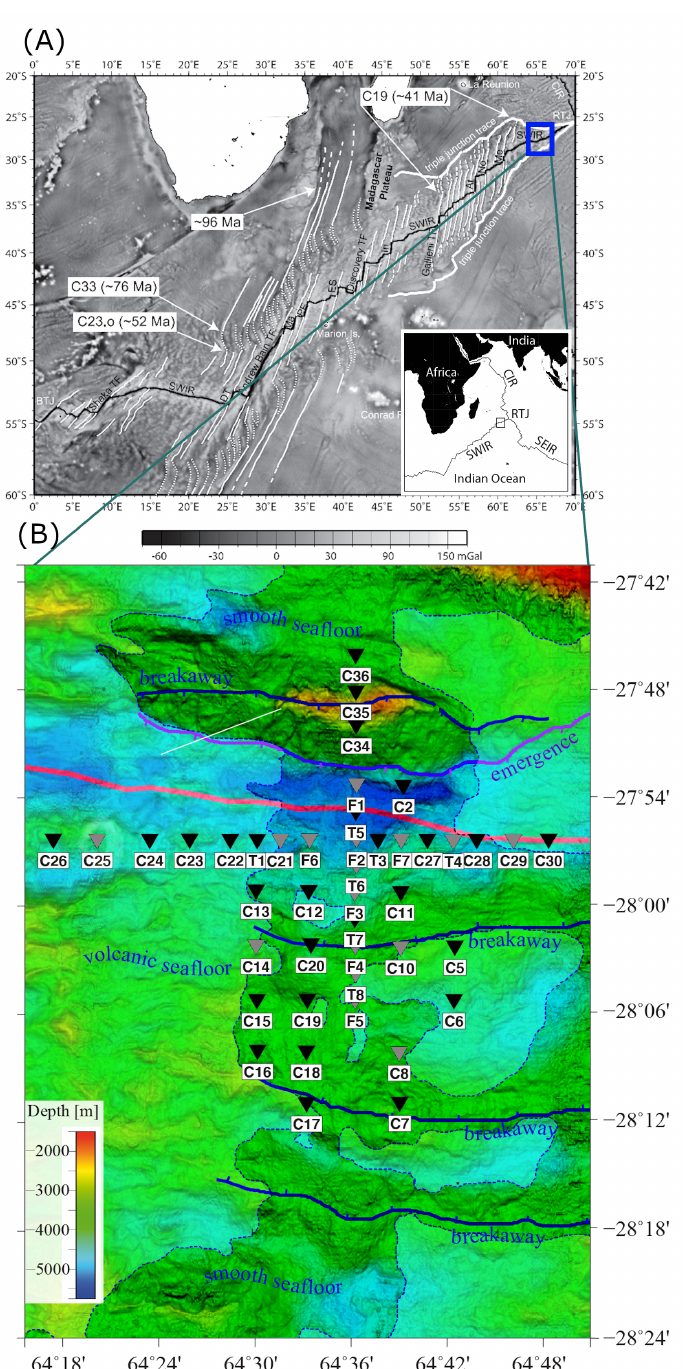
Figure 1. ( A ) Free-air gravity anomalies over Southwest Indian Ridge (SWIR). The thin black line shows SWIR axis. Variation of fracture zones orientation represents the variation of spreading direction with time [17]. The blue rectangle marks our study area. ( B ) Bathymetry map of the study area. The locations of ocean bottom seismometers are shown by reverse triangles. The final stations used for inversion are indicated by black color and the removed stations based on data analysis are shown by gray color. Most of the stations have been placed on smooth seafloor. The red thick line is the axis and the purple line is indicating the emergence of the axial detachment fault system. The breakaway of the active fault is located at the top of the northern axial valley and suggested breakaways of inactive faults are seen in the southern Antarctic